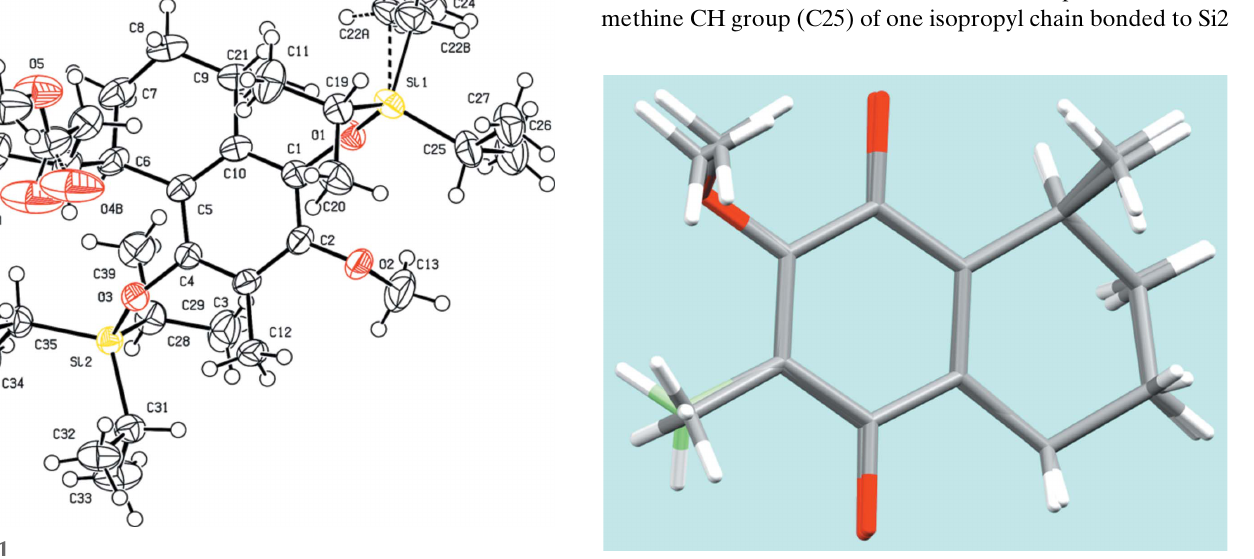
Figure 3 Overlay plot of the 1,2,3,4-tetrahydronaphthalene moiety in ( 2 ) and ( 8 ). For better distinction, the methyl C12 atom in ( 2 ) is given in light green.